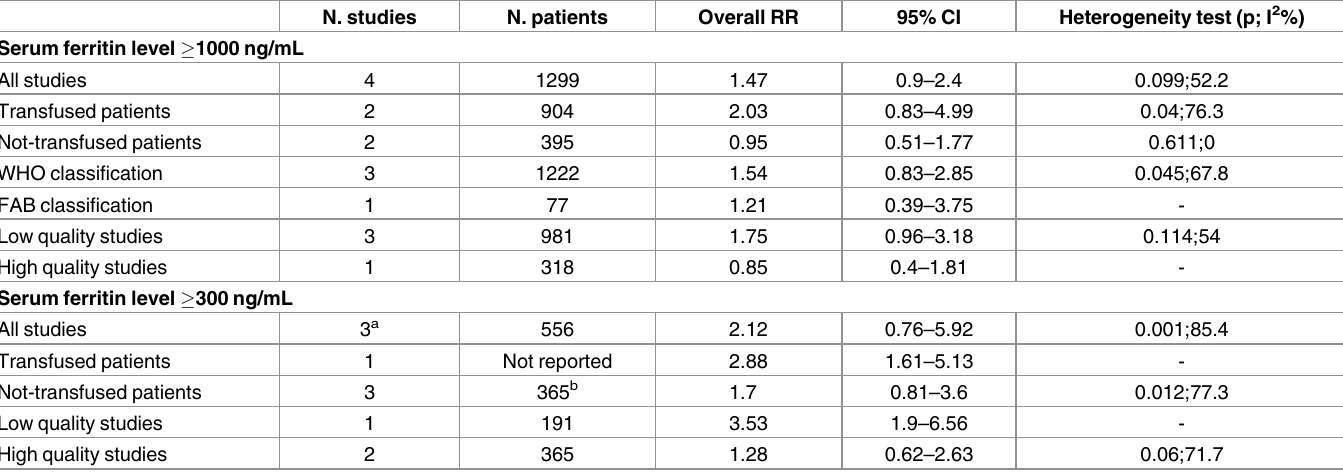
Table 3. Summaryof overall and subgroup analysis describing the association between OS and SF levels in patients with MDS. N.